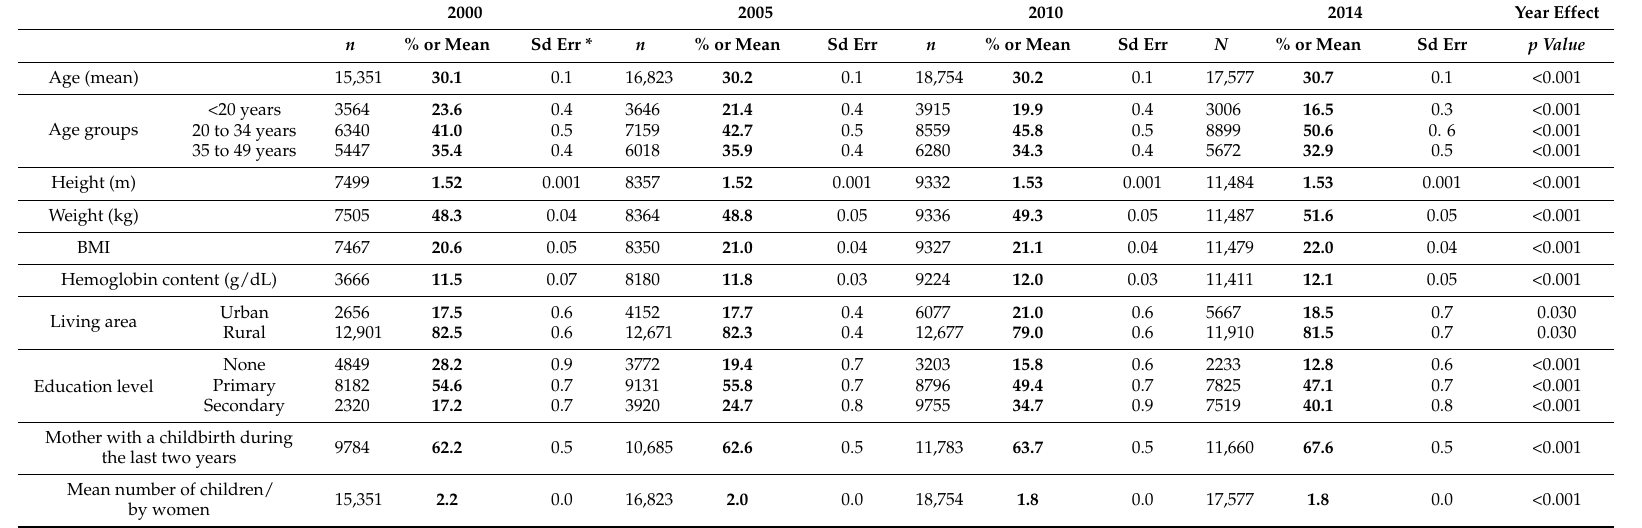
Table 1. Characteristics of the women included in DHS surveys in 2000, 2005, 2010, and